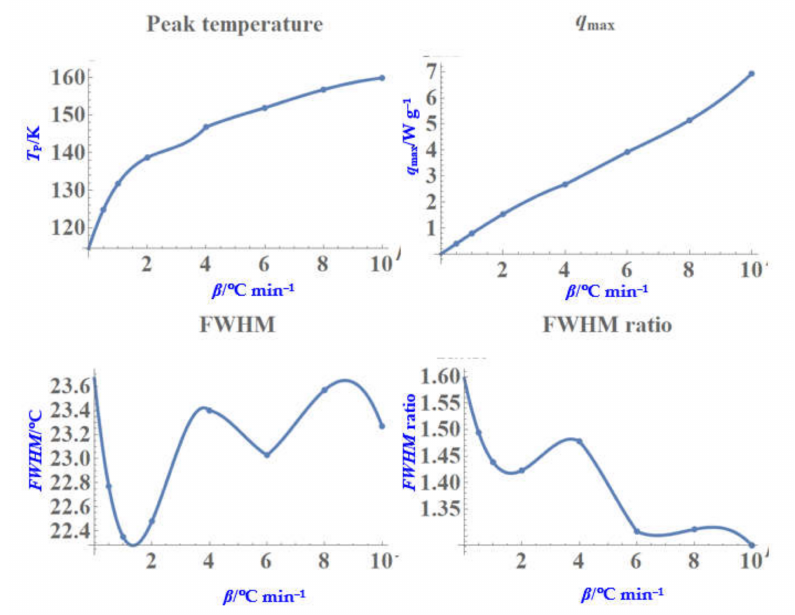
Figure 15. Plots of the characteristic temperatures and heat flux versus various of β . The three predicted β values (5, 9, and 11 ◦ C min − 1 ) were chosen for simulation of the peak curve of the estimated experiment and plotted as shown in Figure 16. Therefore, these simulation results could be regarded as new DSC measurements from the figure.